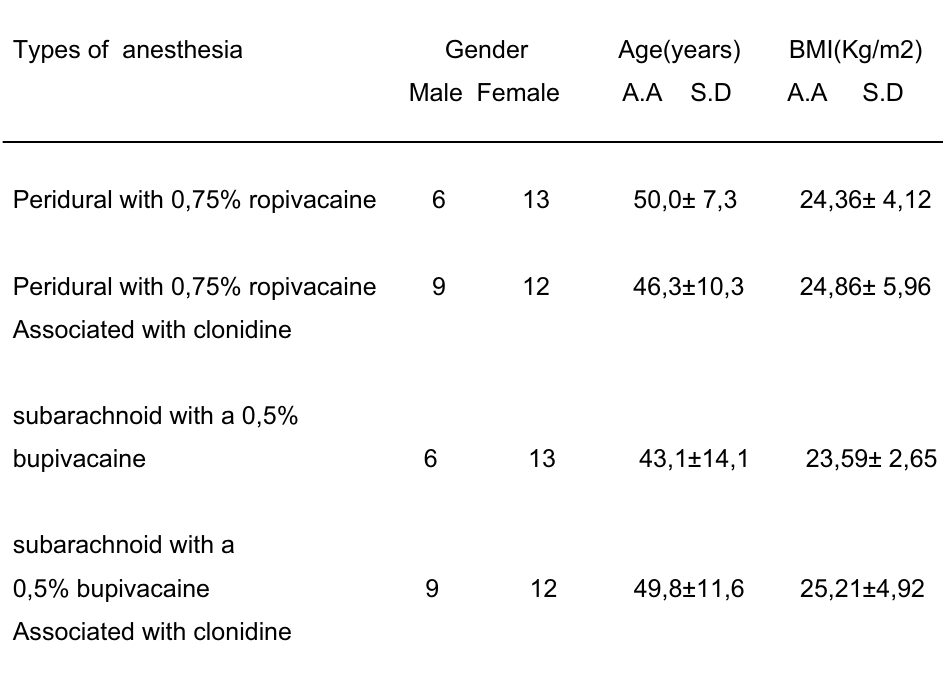
TABLE 1 – Data from patient undergone hemorroidectomy under peridural anesthesia with 0,75% ropivacaine associated or not with clonidine, and the subarachnoid anesthesia with a 0,5%